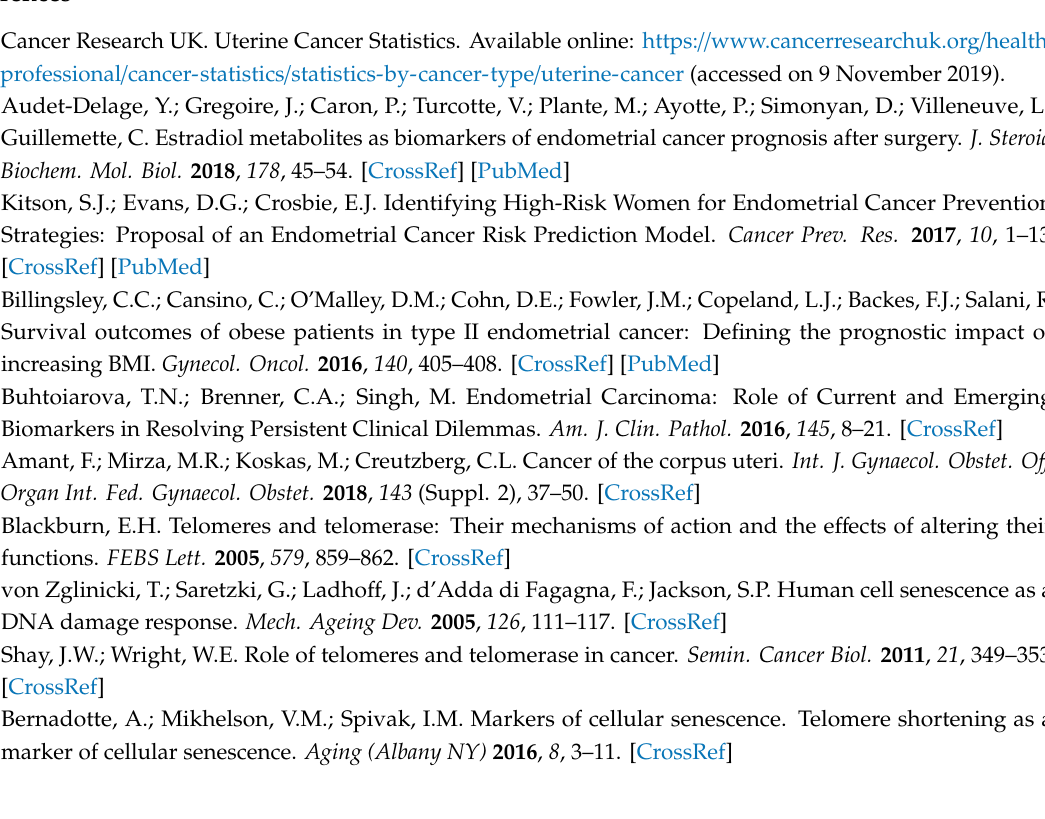
Figure S1: TFBS Z-Score and Fisher Score, Figure S2: PCA, Figure S3: Telomerase and Shelterin Complex Interactions, Table S1: Telomere and Telomerase Associated Genes and Proteins, Table S2: TCGA RNASeqV2 Normalised Expression Data, Table S3: TCGA-UCEC Clinical Data, Table S4: TCGA-UCS Clinical Data, Table S5: DEGs-Cancer-Healthy, Table S6: DEGs-Endometrioid-Healthy, Table S7: DEGs-Serous-Healthy, Table S8: DEGs-Carcinosarcoma-Healthy, Table S9: Common Upregulated Genes Between EC Subtypes, Table S10: Common Downregulated Genes Between EC Subtypes, Table S11: DEGs-Endometrioid Grade 3–1, Table S12: DEGs-Stage IV-I, Table S13: Biological Process GO Terms for DEGs (Enrichr), Table S14: Molecular Function GO Terms for DEGs (Enrichr), Table S15: Cellular Compon ent GO Terms for DEGs (Enrichr), Table S16: KEGG Pathways for DEGs (Enrichr), Table S17: Revised Biological Process GO Terms for DEGs (REVIGO), Table S18: Revised Molecular Function GO Terms for DEGs (REVIGO), Table S19: Revised Cellular Component GO Terms for DEGs (REVIGO), Table S20: PPI Network Nodes, Table S21: Nodes of MCODE Module, Table S22: Biological Process GO Terms for Module (Enrichr), Table S23: Molecular Function GO Terms for Module (Enrichr), Table S24: Cellular Component GO Terms for Module (Enrichr), Table S25: KEGG Pathways for Module (Enrichr), Table S26: Revised Biological Process GO Terms for Module (REVIGO), Table S27: Revised Molecular Function GO Terms for Module (REVIGO), Table S28: Revised Cellular Component GO Terms for Module (REVIGO), Table S29: Stage IV-I DEGs–Node Scores, Table S30: TFBS, Table S31: TFBS Control Analysis 1, Table S32: TFBS Control Analysis 2, Table S33: Therapeutic Targets, Table S34: Survival Analysis, Table S35: Common DEGs Between Grades, Stages and